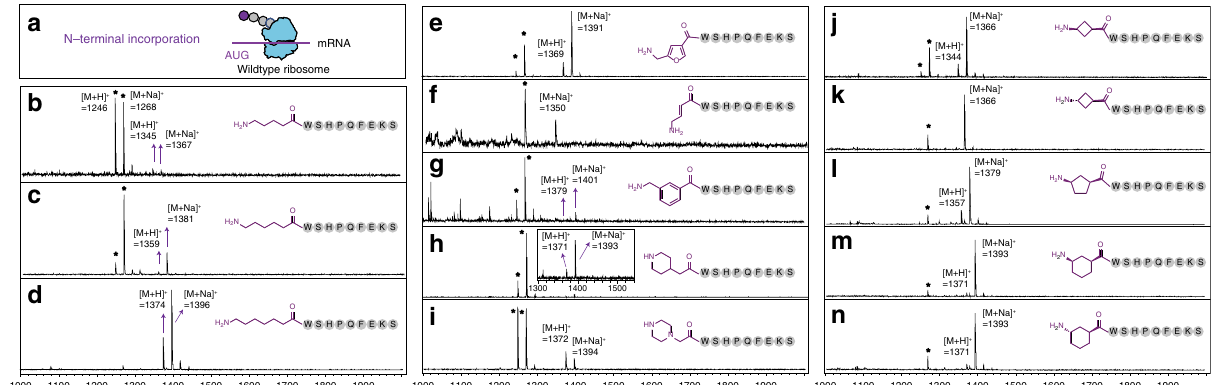
Fig. 4 Ribosomal synthesis of N-terminal functionalized peptides with backbone-extended monomers. a All backbone-extended amino acids ( 3 – 15 ) charged to tRNA fMet (CAU) by Fx were incorporated into the N-terminus of a peptide by ribosome-mediated polymerization in the PURExpress TM system. The peptides were puri fi ed via the Streptavidin tag (WSHPQFEK) and characterized by MALDI mass spectrometry. The observed mass of each peptide corresponds to the theoretical mass, which is b [M + H] + = 1345; [M + Na] + = 1367, c [M + H] + = 1359; [M + Na] + = 1381, d [M + H] + = 1373; [M + Na] + = 1395, e [M + H] + = 1369; [M + Na] + = 1391, f [M + Na] + = 1351, g [M + H] + = 1379; [M + Na] + = 1401, h [M + H] + = 1371; [M + Na] + = 1393, i [M + H] + = 1372; [M + Na] + = 1394, j [M + H] + = 1343; [M + Na] + = 1365, k [M + Na] + = 1365, l [M + H] + = 1357; [M + Na] + = 1379, m [M + H] + = 1371; [M +